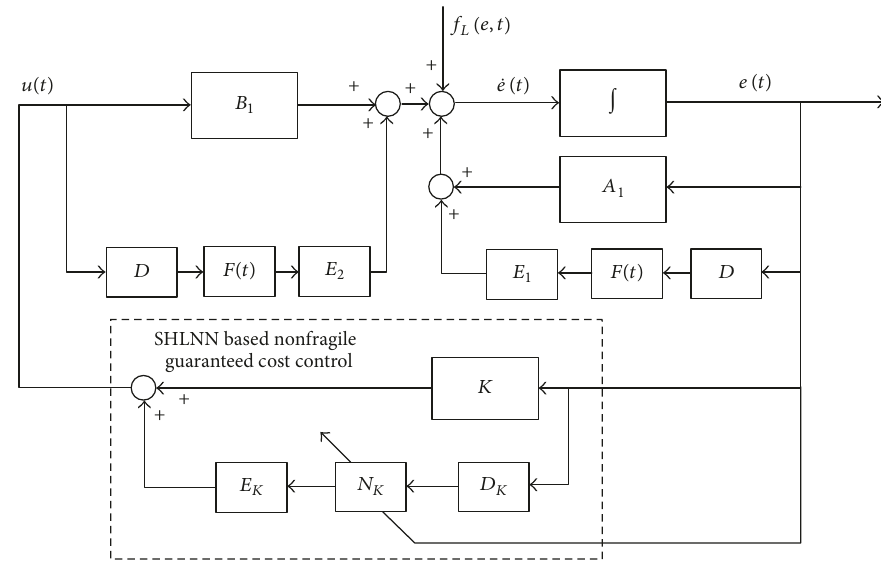
Figure 1: SHLNN based nonfragile robust control